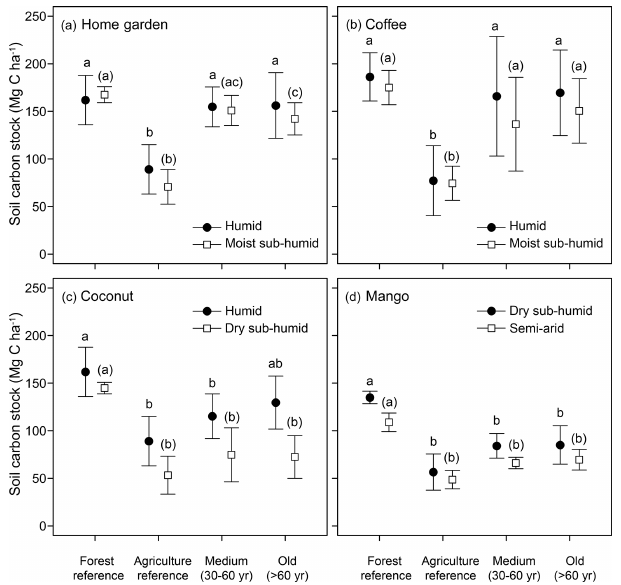
Figure 2. Absolute SOC stocks (0–100cm) in the four different land-use systems. Each graph shows the respective forest and agri- culture references and the two AFS age categories (medium and old) in the two different climatic zones. Point represents the mean of seven plots, while error bars indicate the 95% confidence inter- vals based on the Student’s T distribution. Within each graph the letters indicate significant differences ( P <0.05; one-way analysis of variance) between land-use systems for each climate